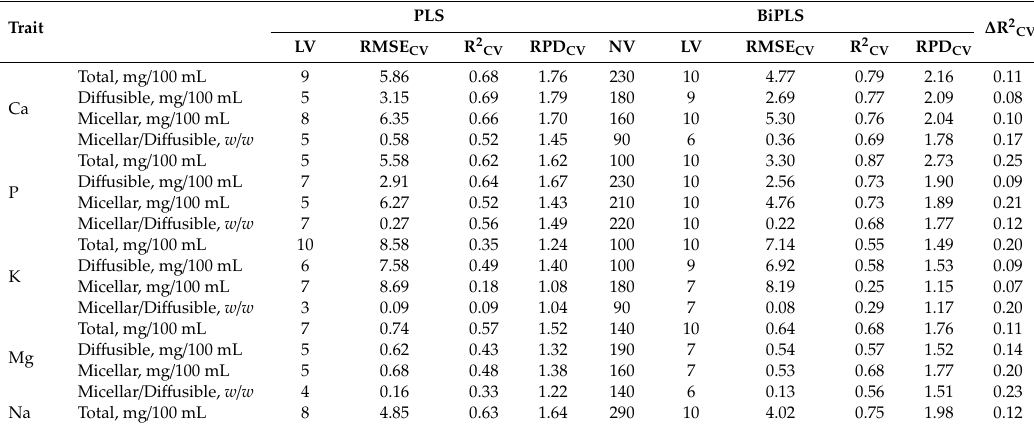
Table 2. Fitting statistics of prediction models for milk minerals and ratio between micellar and di ff usible fractions ( w / w ) in cross-validation obtained using partial least squares (PLS) and backward interval PLS (BiPLS) analysis (n =